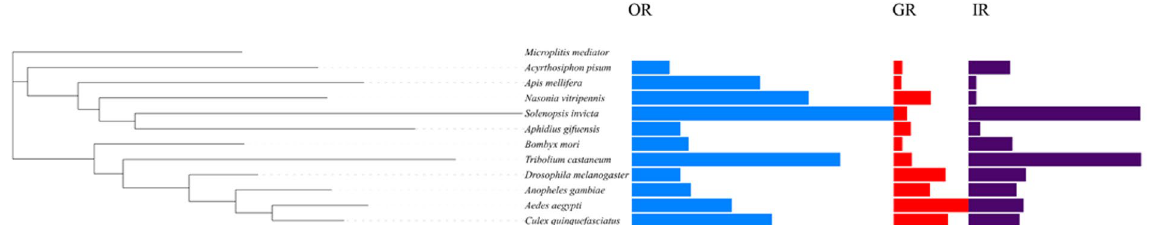
Figure 3. The number of chemosensory genes in different insect species. The digits by the histogram bars represent the numbers of chemosensory receptor genes in different subfamilies. A phylogenetic tree showing the phylogenetic relationships between these species is illustrated on the left. The data are obtained from the current study for Microplitis mediator , Acyrthosiphon pisum , Apis mellifera , Nasonia vitripennis , Solenopsis invicta , Bombyx mori , Tribolium castaneum , Drosophila melanogaster , Anopheles gambiae , Aedes aegypti , and Culex quinquefasciatus .